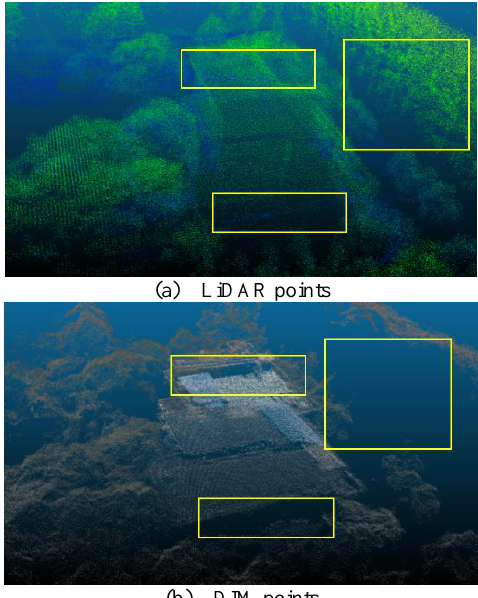
Figure 1. Comparison between LiDAR points and DIM points